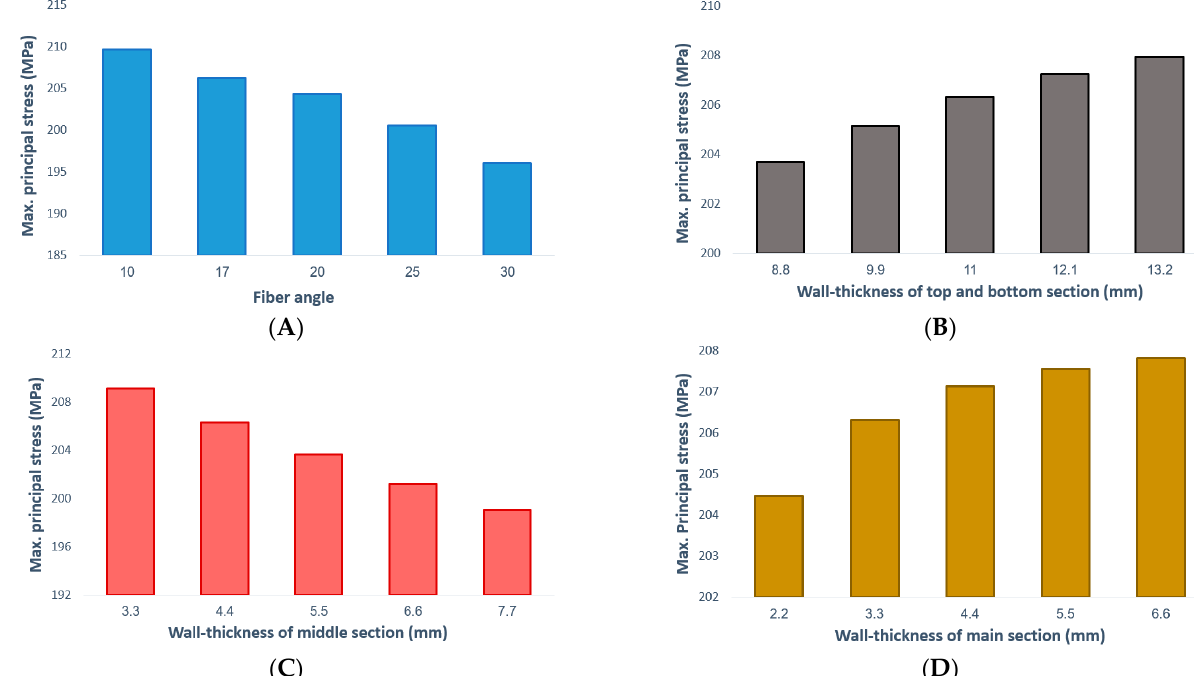
Figure 8. Maximum principal stress created in the critical area of the composite CNG tank in terms of various parameters including ( A ) variation of the fiber angle and the assumption T1 = 11 mm, T2 = 4.4 mm, and T3 = 3.3 mm, ( B ) variation of the wall-thickness of the top and bottom sections and the assumption that the fiber angle = 17, T2 = 4.4 mm, and T3 = 3.3 mm, ( C ) variation of the wall-thickness of the middle section and the assumption that the fiber angle = 17, T1 = 11 mm, and T3 = 3.3 mm, and ( D ) variation of the wall-thickness of the main section and the assumption that the fiber angle = 17, T1 = 11 mm, and T2 = 4.4 mm.